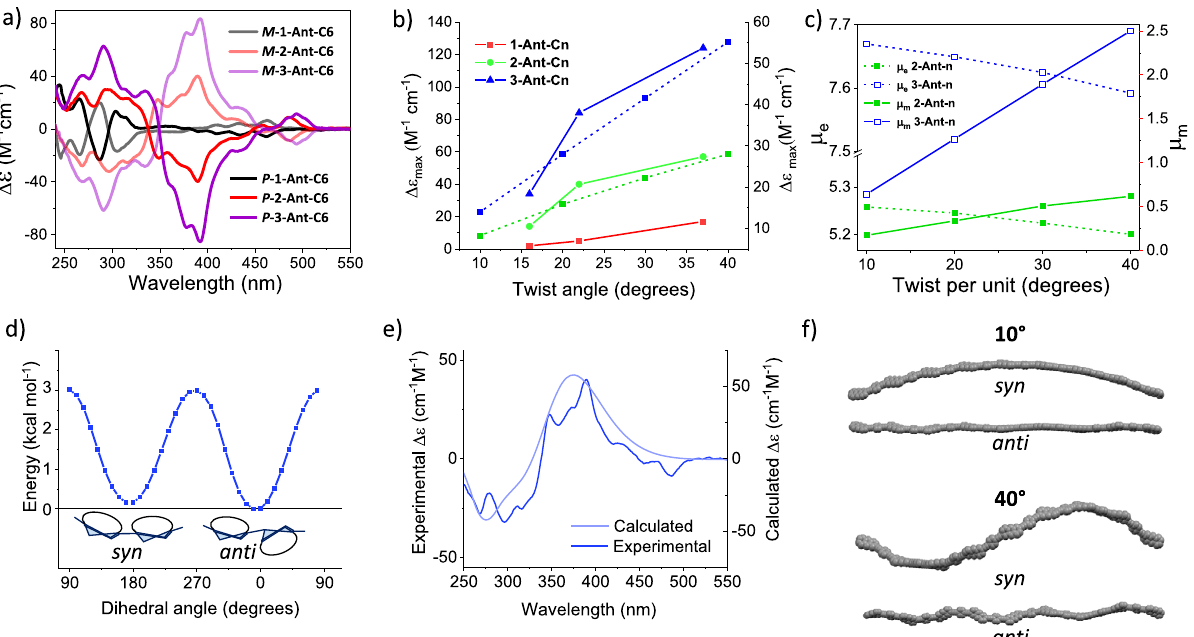
Fig. 5 Chiroptical properties and secondary helical structures of twistacenes. a Electronic circular dichroism (ECD) spectra of enantiopure n-Ant-C6 ( n = 1 – 3), measured in chloroform. b Maximal molar circular dichroism ( Δ ε max ) for n-Ant-C measured experimentally (solid lines, left y -axis) and computationally (dashed lines, right y -axis). c Calculated electronic transition dipole moment ( μ e , dashed lines) and magnetic transition dipole moment ( μ m , solid lines) for 2-Ant-Cn (green) and 3-Ant-Cn (blue). The backbone twist angles were determined computationally. d Calculated rotation energy around the inter-unit acetylene bond of 2-Ant-C6 . Calculated at the B3LYP-D3/6-31G(d) level of theory. e Measured (dark blue) and calculated (light blue) ECD spectra, consisting of averaged syn and anti conformers. f Optimized (B3LYP/6-31G(d)) structures of anthracene-phenyl skeleton, in syn or anti conformations, with each anthracene unit twisted in 10° (top) or 40°